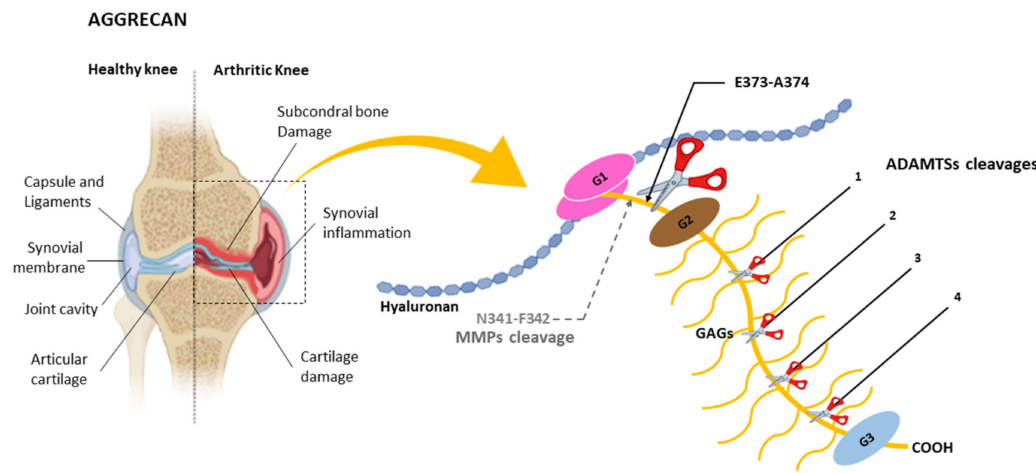
Figure 3. Schematic representation of an arthritic knee and aggrecan. G1, G2 and G3 indicate globular domains. Cleavage at the E373-A374 bond by the ADAMTSs in the interglobular domain (IGD) between G1 and G2 domains is indicated. This position is related to the development of juvenile joint diseases, causing inflammation in parts of the body like the knee. GAGs indicates glycosaminoglycans. (This position corresponds to the E392-A374 bond in reference [48]). Relative positions of additional cleavages sites (1,2,3,4) within the chondroitin sulphate-rich region are also indicated. These positions correspond to the E1279-G1280, E1467-L1468, E1572-A1573 and E1672-L1673 bonds identified in mouse cartilage aggrecan as shown in reference [72]. Main cleavage site by MMPs (N341-F342) in the IGD domain is also indicated. (This position corresponds to the N360-F361 bond in reference